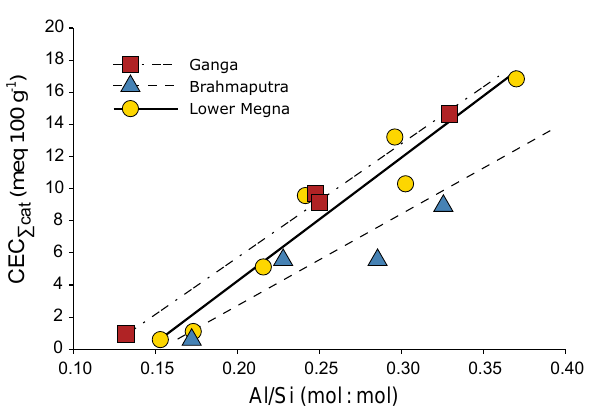
Figure 3. CEC of sediment samples from the Ganga, Brahmaputra and lower Meghna rivers as a function of Al / Si that is used here as a proxy for grain size and sediment sorting in the river